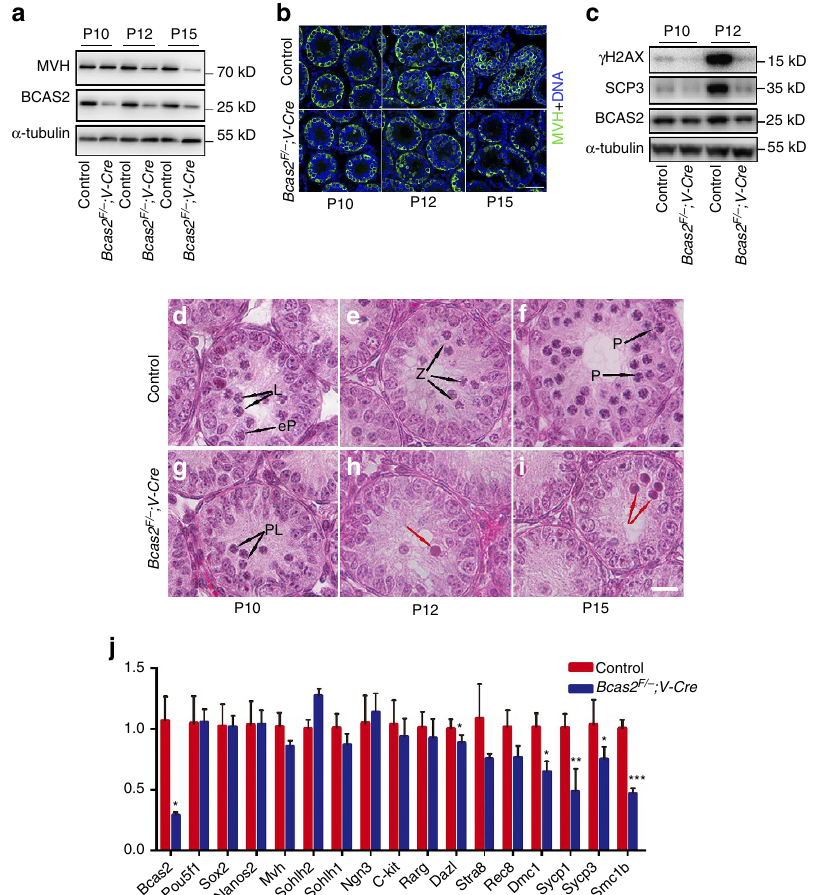
Figure 3 | Spermatogenesis could not progress into meiosis in Bcas2 F/ (cid:2) ;Vasa-Cre testes. ( a ) Western blotting analysis of MVH in control and Bcas2 F/ (cid:2) ;Vasa-Cre testes at P10, P12 and P15. a -tubulin was used as the loading control. ( b ) IF staining of MVH in control and Bcas2 F/ (cid:2) ;Vasa-Cre testes at P10, P12 and P15. The DNA was stained with Hoechst 33342. Scale bar, 50 m m. ( c ) Western blotting analyses of SCP3 and g H2AX in control and Bcas2 F/ (cid:2) ;Vasa-Cre testes at P10 and P12. a -tubulin was used as the loading control. ( d – i ) Hematoxylin and eosin (H&E) staining of control ( d – f ) and Bcas2 F/ (cid:2) ;Vasa-Cre testes ( g – i ) at P10, P12 and P15. Spermatogenic cells were shown in cross-sections of seminiferous tubules from control and Bcas2 F/ (cid:2) ;Vasa-Cre testes. Scale bar, 15 m m. Black arrows indicate the representative stages of the spermatocytes. L, leptotene; eP, early pachytene spermatocytes; Z, zygotene spermatocytes; P, pachytene spermatocytes; PL, pre-leptotene spermatocytes; red arrows, apoptotic cells. ( j ) Real-time RT-PCR analysis of marker gene expression in pre-meiotic testes from control and Bcas2 F/ (cid:2) ;Vasa-Cre males at P9 with Gapdh as the internal control. (* P o 0.05; ** P o 0.01; *** P o 0.001, n ¼ 5). Error bars represent